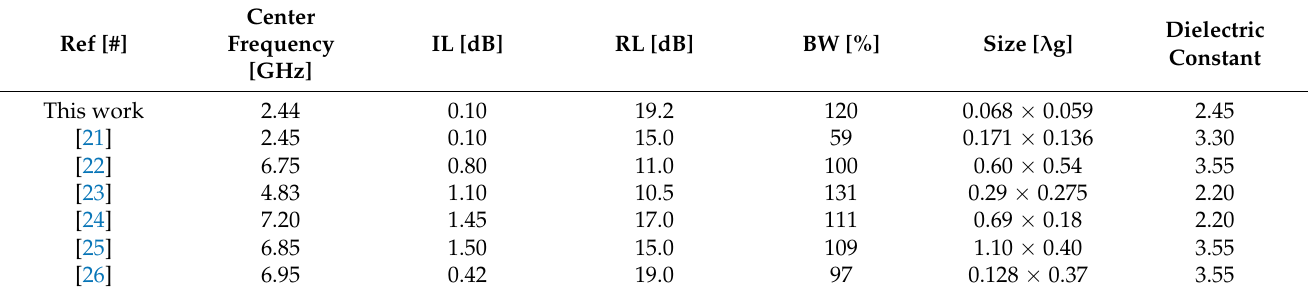
Table 3. Comparison between the proposed BPF and